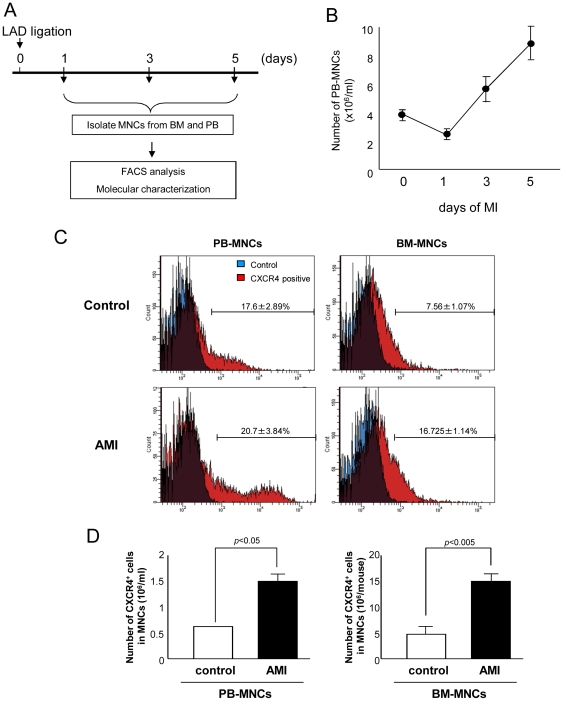
AMI increases the numbers of BM-MNCs and CXCR4 positive MNCs.(A) MNCs were isolated at 1, 3 and 5 days after left anterior descending artery ligation (LAD) and analyzed for molecular characterization. (B) The number of PB-MNCs decreased at one day after LAD ligation and increased gradually up to 5 days (n≥10 in each groups). (C) The percentage of CXCR4 positive cells in MNCs increased in both PB and BM after LAD ligation as compared to control. (n = 8 in control group and n = 6 in AMI group). (D) Densitometric analysis of CXCR4 positive MNCs counted after LAD ligation.